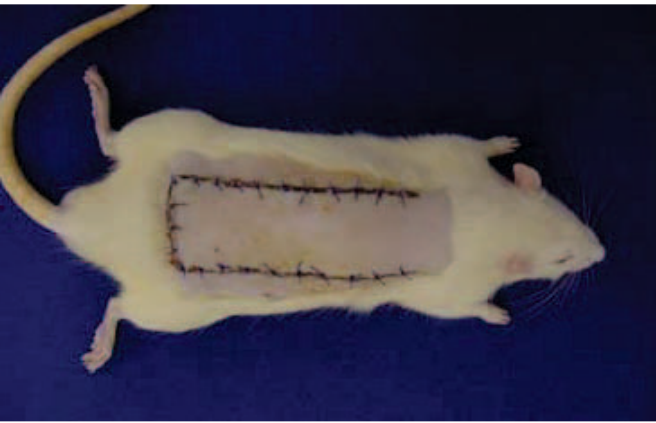
FIGURE 3 - Skin flap sutured in place with 4-0 monofilament nylon.